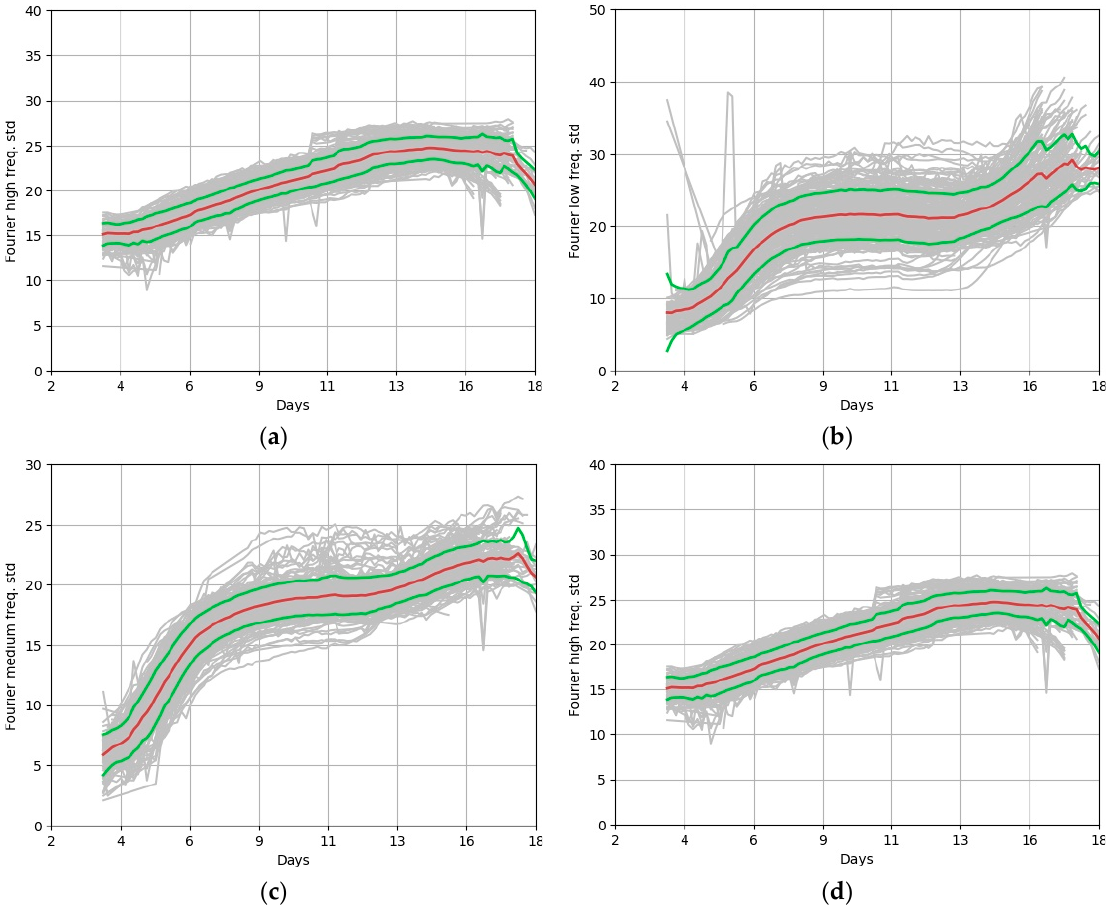
Figure A3. Results of Fourier analysis for high pass mean ( a ), low pass standard deviation ( b ), medium pass standard deviation ( c ) and high pass standard deviation ( d ) filter intensity. The brown line represents the medium value, the green line represents standard deviation.